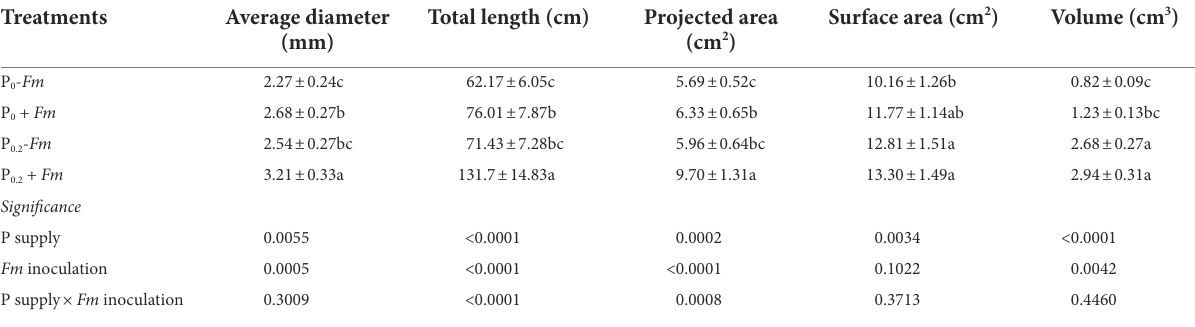
TABLE 3 Effects of Funneliformis mosseae and P supply on root morphology of Polygonum cuspidatum . Treatments